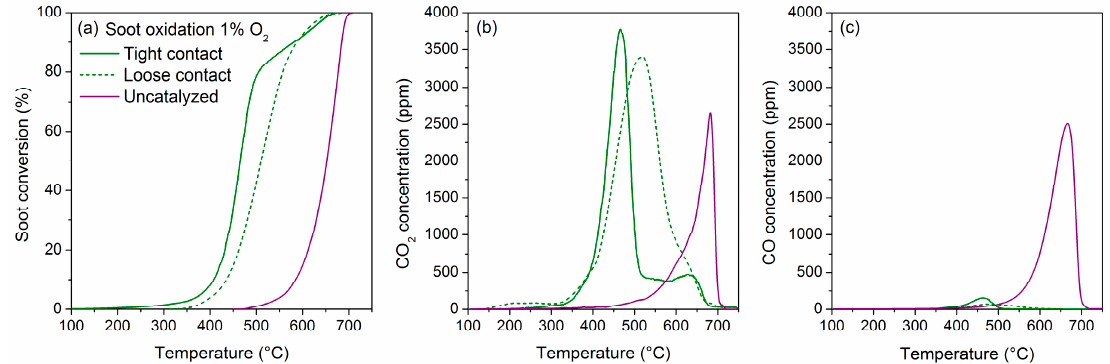
Figure 9. Soot conversion ( a ), CO 2 ( b ) and CO ( c ) concentration at the outlet as a function of the temperature during the soot oxidation tests performed over the Ce50Pr50 catalyst in low-O 2 conditions.